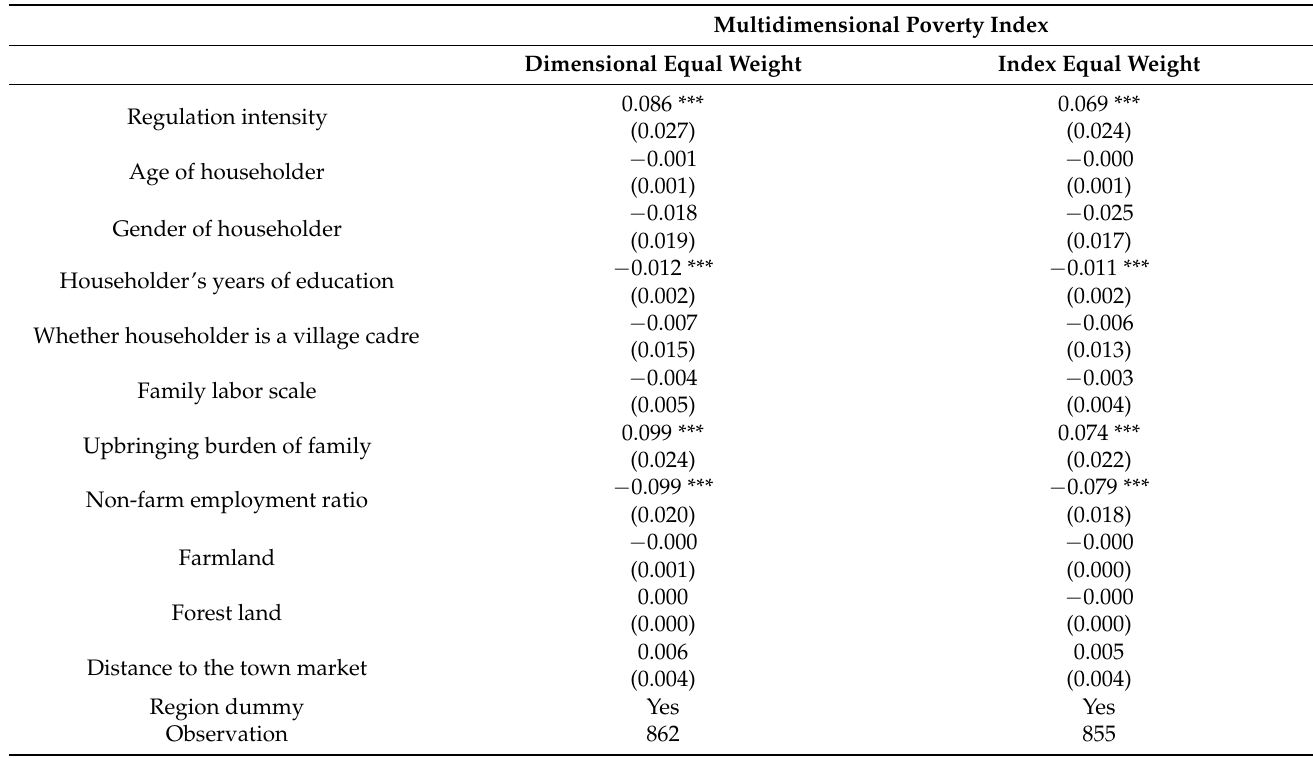
Table 6. Regulation intensity and the multidimensional poverty of